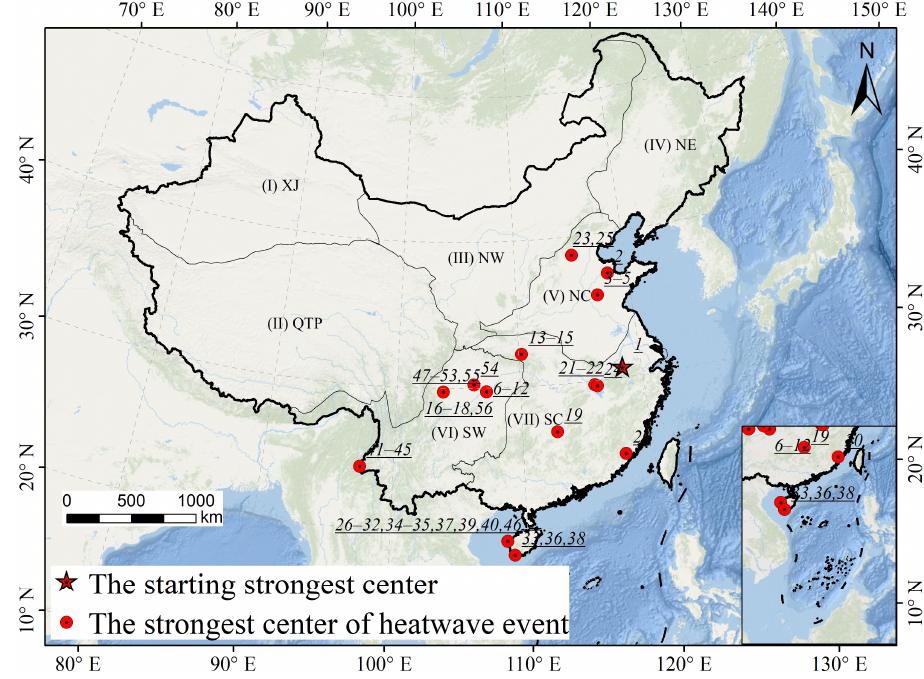
Figure 15. The dynamic variations in the strongest center location of the heatwave event with the longest duration. The number represents the i-th day of the duration.